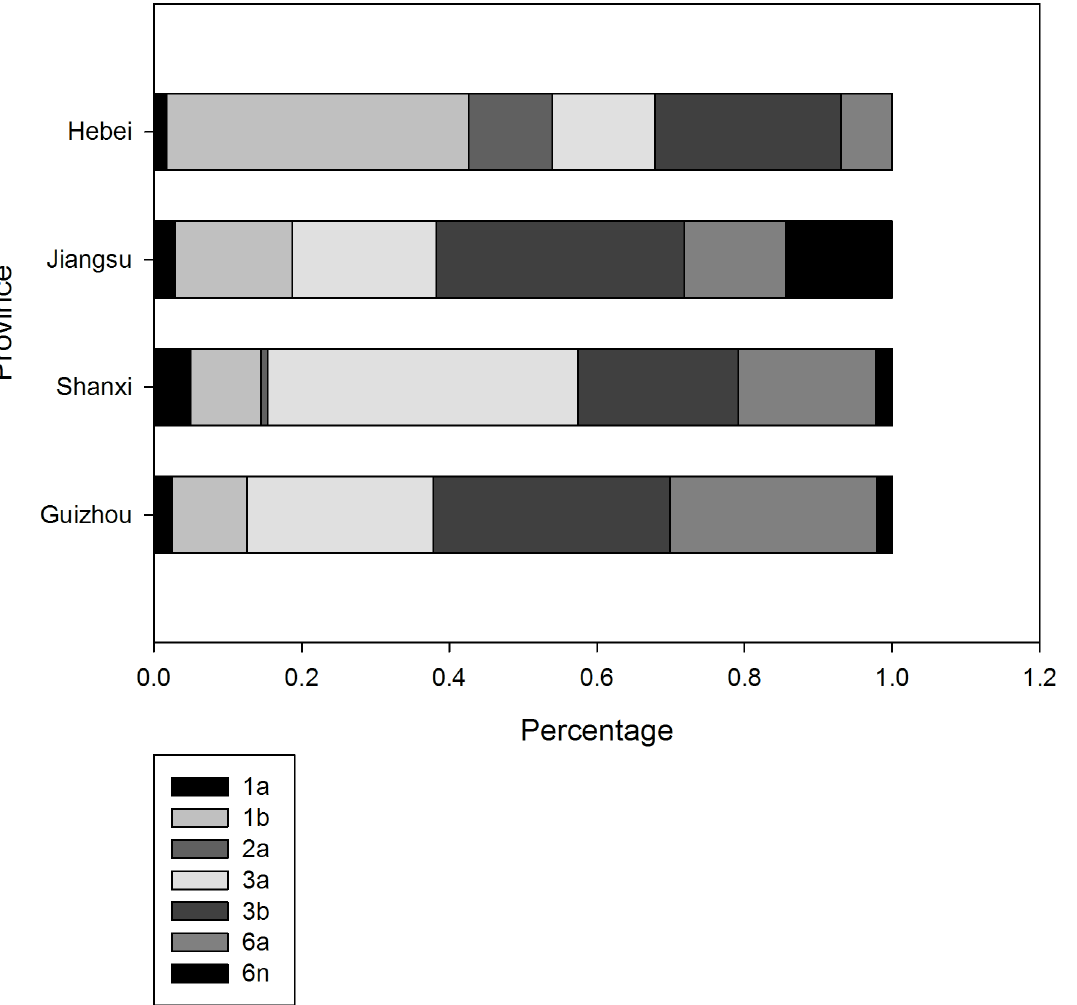
Fig 2. The distribution of HCV subtypes among Chinese drug users in four